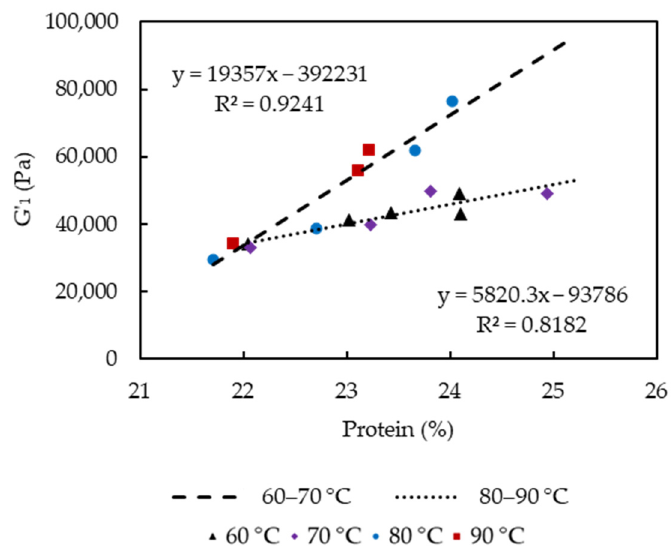
Figure 8. Plot of storage modulus versus curd protein content.